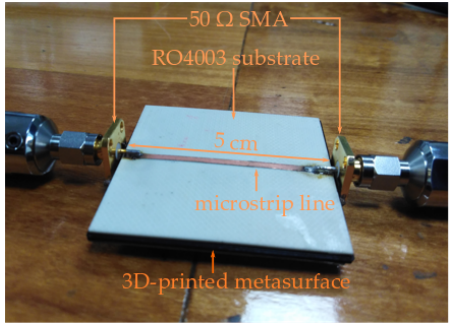
Figure 15. Constructed metasurface with suspended microstrip line.